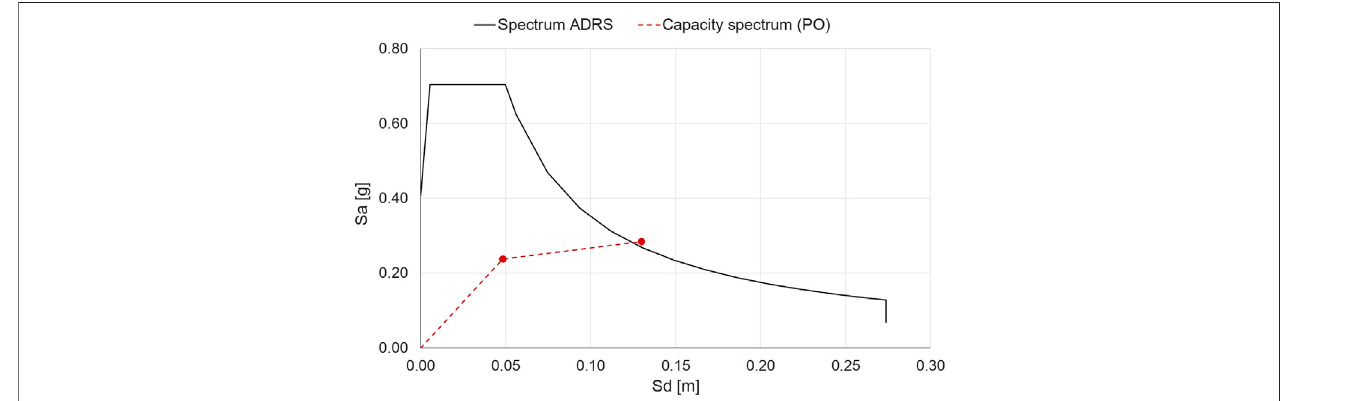
FIGURE 12 | Comparison between capacity spectrum (dashed red line) and ADRS (black line) for the de fi nition of the performance point. Note: S a and S d are, respectively, the pseudo acceleration and the displacement spectral